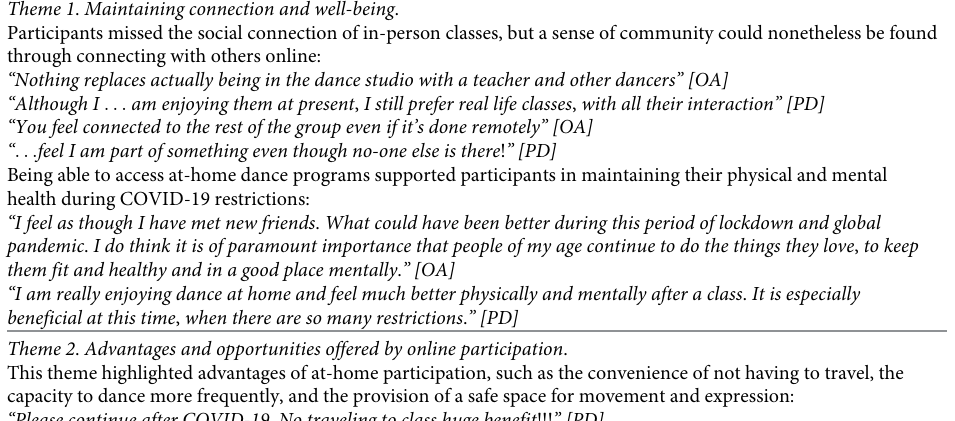
Table 3. Themes generated from open comments of older adults (OA) and individuals with PD